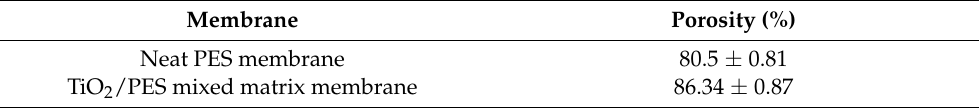
Table 2. The porosity of a neat PES membrane and the TiO 2 /PES mixed matrix membrane.